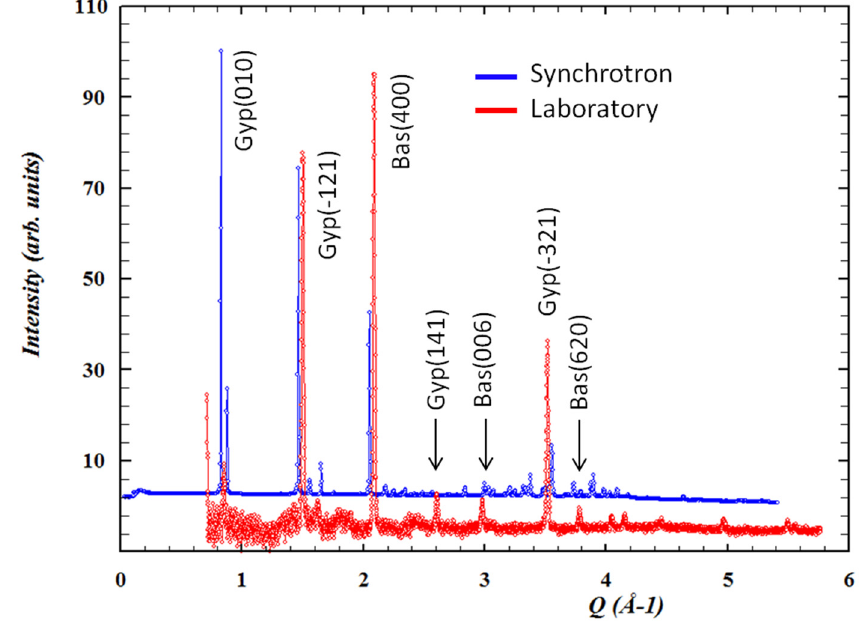
Figure 14. C onventional and synchrotron Grazing Incidence X-ray Diffraction (GI-XRD) patterns with identified gypsum and bassanite peaks. Figure from Carreño-Márquez et al. (2018) [77]. Fur- ther permissions related to this figure should be directed to the ACS. Gyp = Gypsum; Bas = Bas- sanite